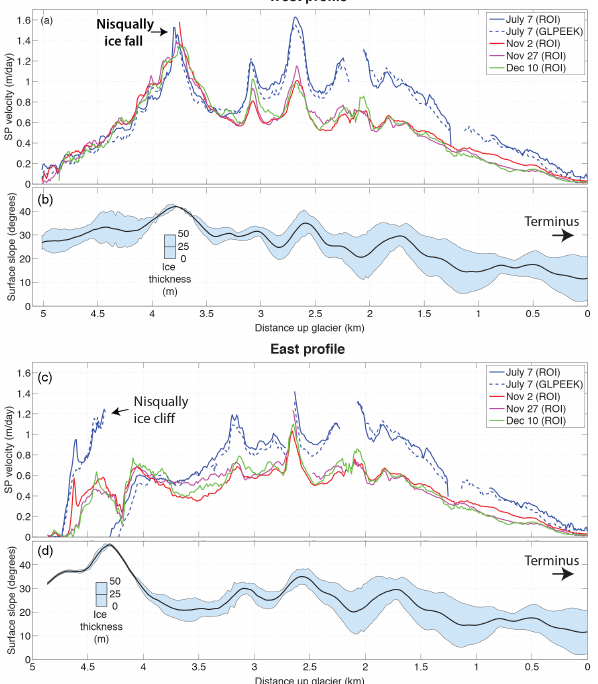
Figure 6. (a) and (c) : slope-parallel velocity profiles along the two branches of Nisqually Glacier (profile lines shown in map view in Fig. 4a) for all sample time periods and viewpoints. (b) and (d) : sur- face slope and ice thickness along each profile line. Surface slope is smoothed identically to that used for slope-parallel corrections (see text); ice thicknesses are estimated from digitized basal contours from Driedger and Kennard (1986) and surface elevations from the 2007/2008 LiDAR (Robinson et al., 2010). Refer to Fig. 5 and Ta- ble 2 for uncertainty estimates.